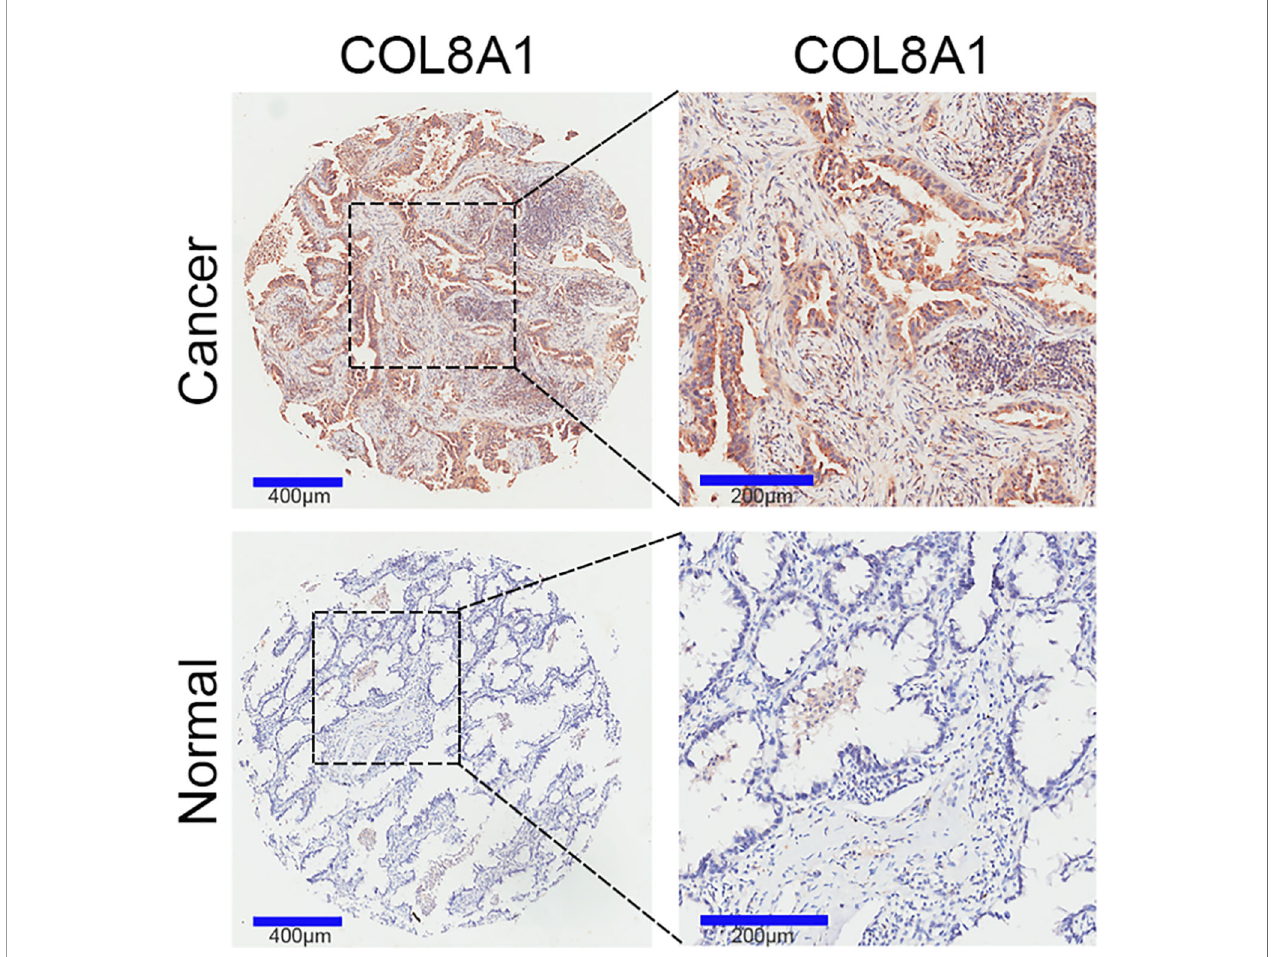
FIGURE 1 | COL8A1 overexpression in NSCLC tissues. COL8A1 expression in 94 NSCLC and 86 paired adjacent normal tissue samples was determined by IHC